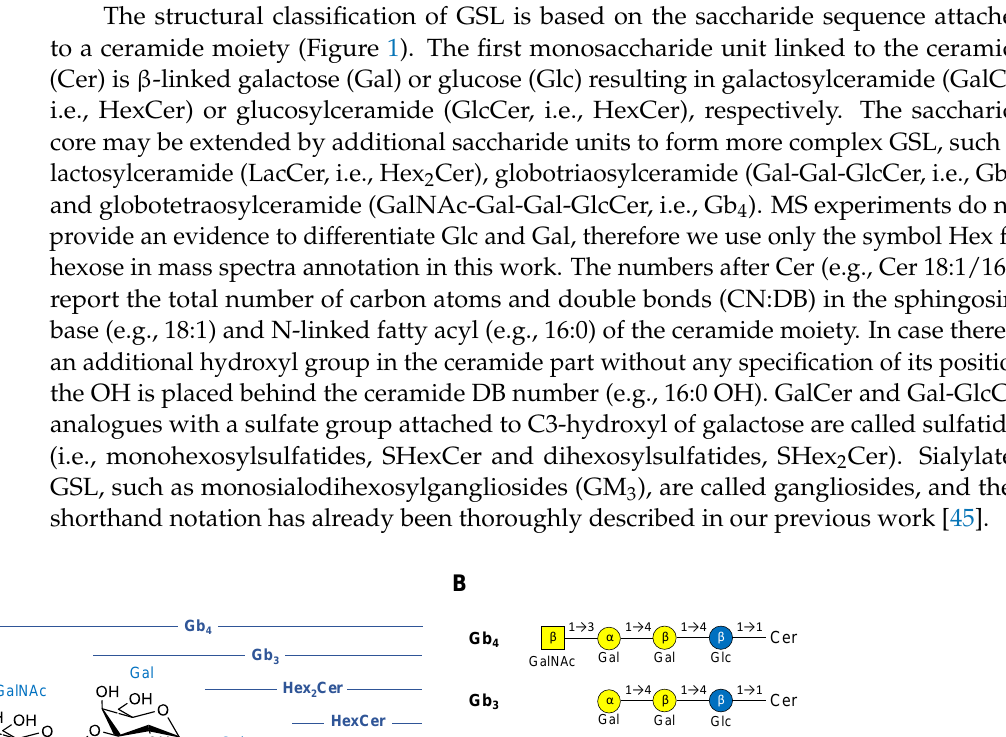
N-hexadecanoyl( i.e. , 16:0)